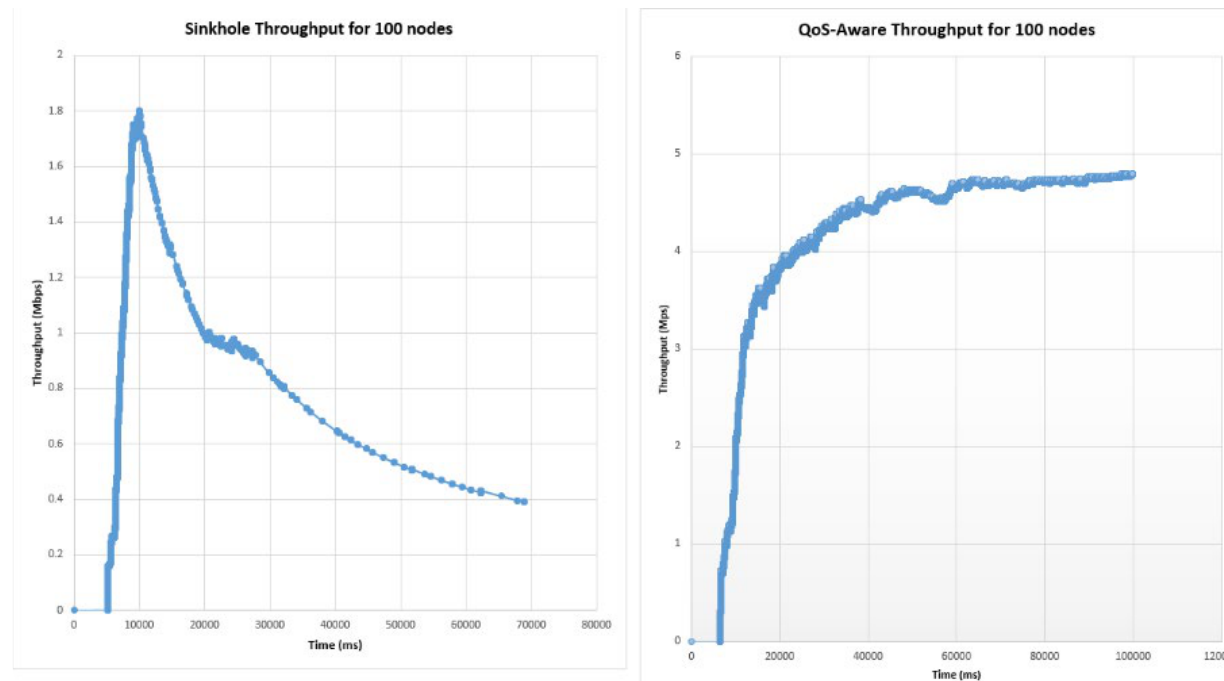
Figure 18. Throughput for sinkhole and framework scenarios.